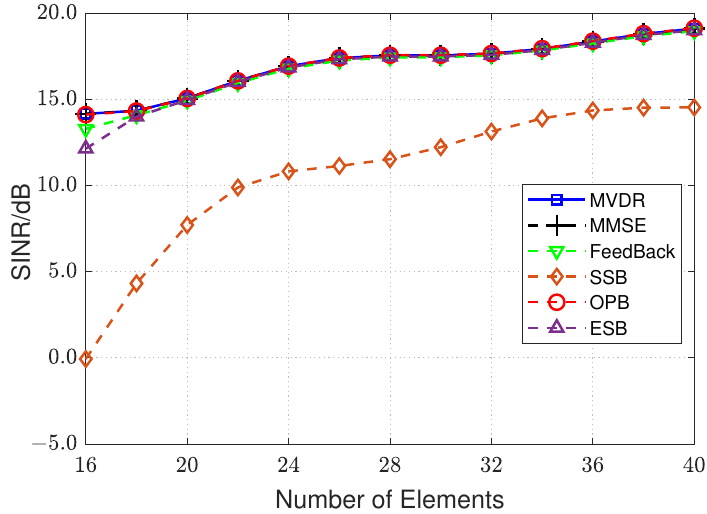
Figure 4. Output SINR versus the number of sensors.